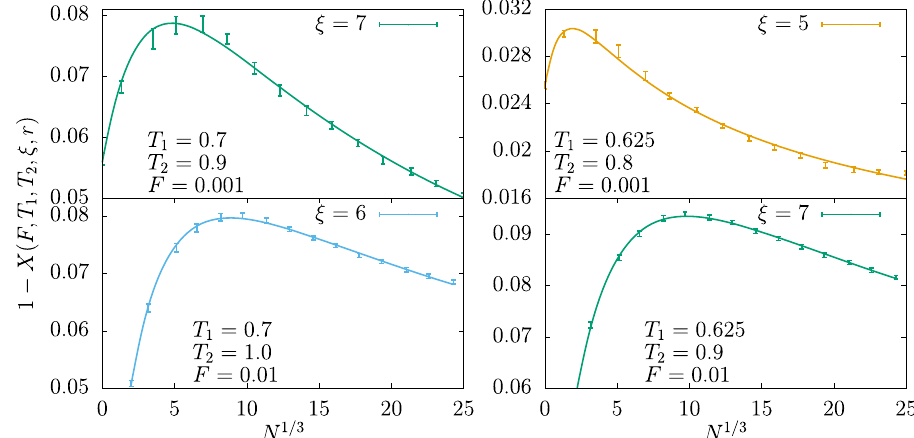
Fig. 4 Emergence of an optimal scale to observe temperature chaos. The difference 1 − X ( F , T 1 , T 2 , ξ , r ) [recall that X ( F , T 1 , T 2 , ξ , r ) is the inverse of the distribution function] as a function of the cubic root N 1 = 3 r of the number of spins in the spheres, as computed for different values of the probability level F , the temperatures T 1 and T 2 , and the coherence length ξ . In this representation, the optimal size of the spheres for the observation of chaos (for given parameters F , T 1 , T 2 and ξ ) appears as the maximum of the curves. Continuous lines are fi ts to a smooth interpolating function, further details can be found in Supplementary Note 2. Error bars represent one standard